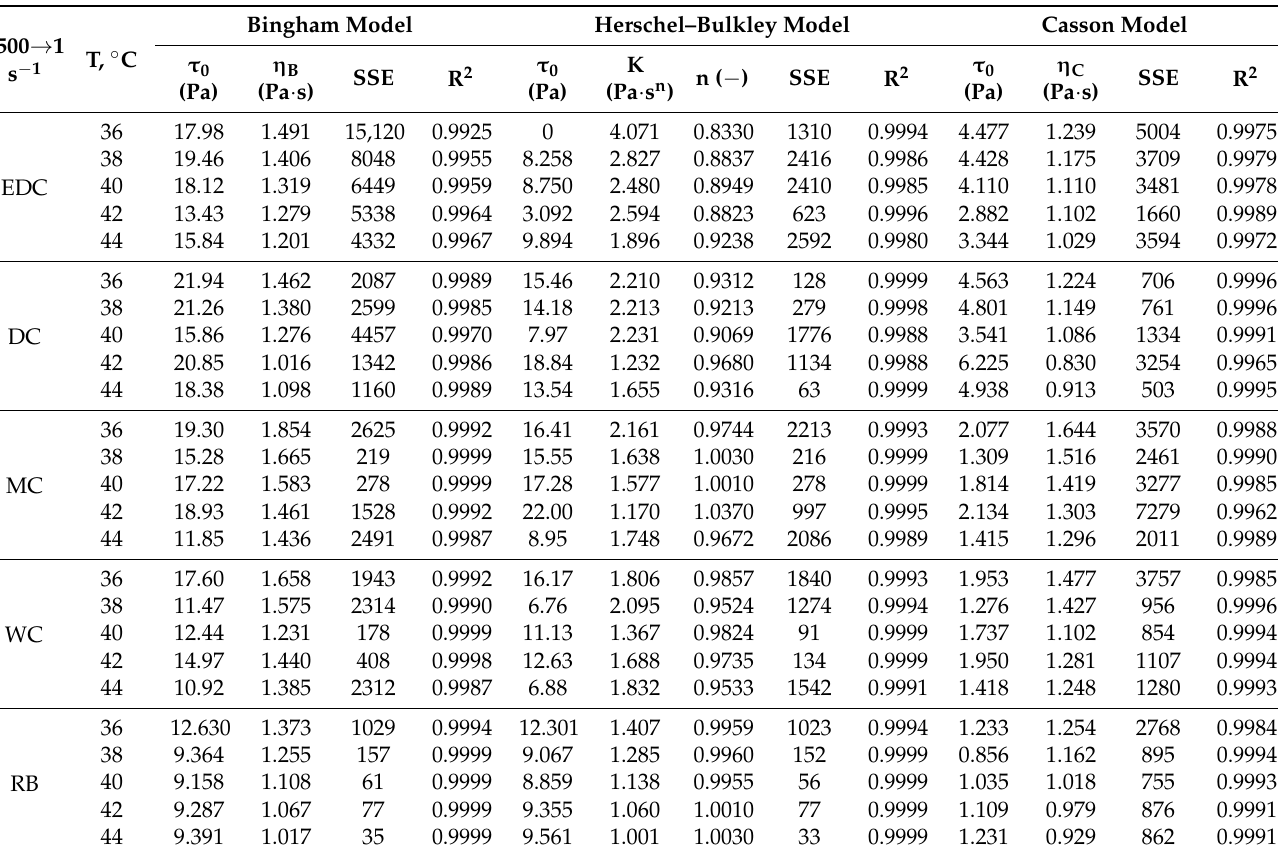
Table 4. Coefficients of the rheological models at a decreasing shear strain rate ( n =